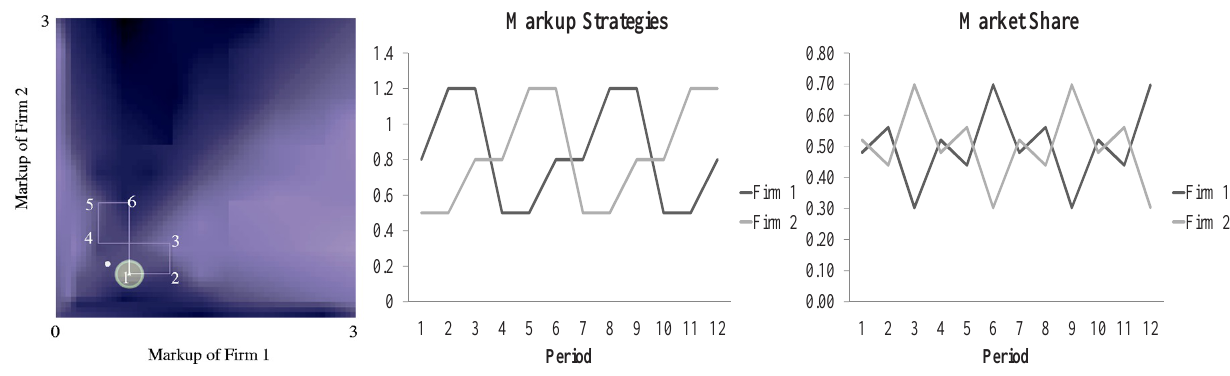
Figure 13. Long-run dynamics of markup rates: sequential